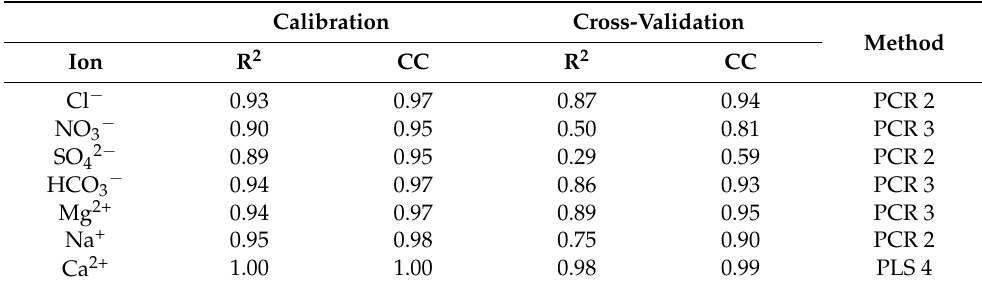
Table 6. Quality parameters of the best predictors for each ion. R 2 : coefficient of determination, proportion of variance explained by the predictor. CC: correlation coefficient between true and predicted